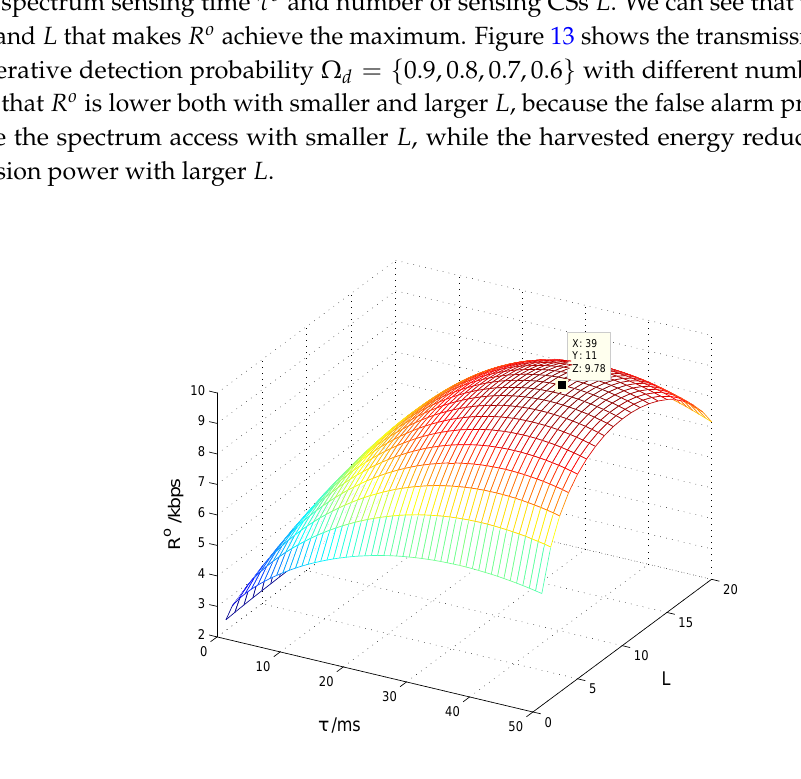
Figure 12. Transmission rate with spectrum sensing time and number of sensing cognitive